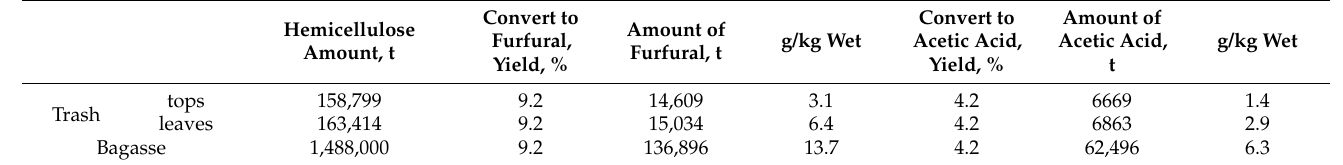
Table 18. Potential amount of furfural produced from trash and bagasse.